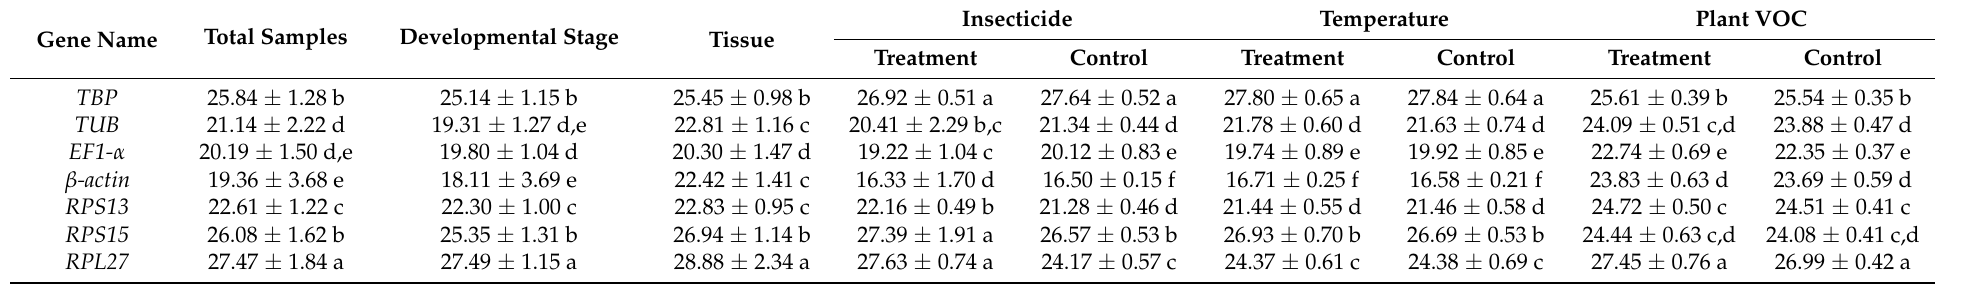
Table 3. Distribution of the Ct values of each candidate reference gene in T. absoluta (mean ±